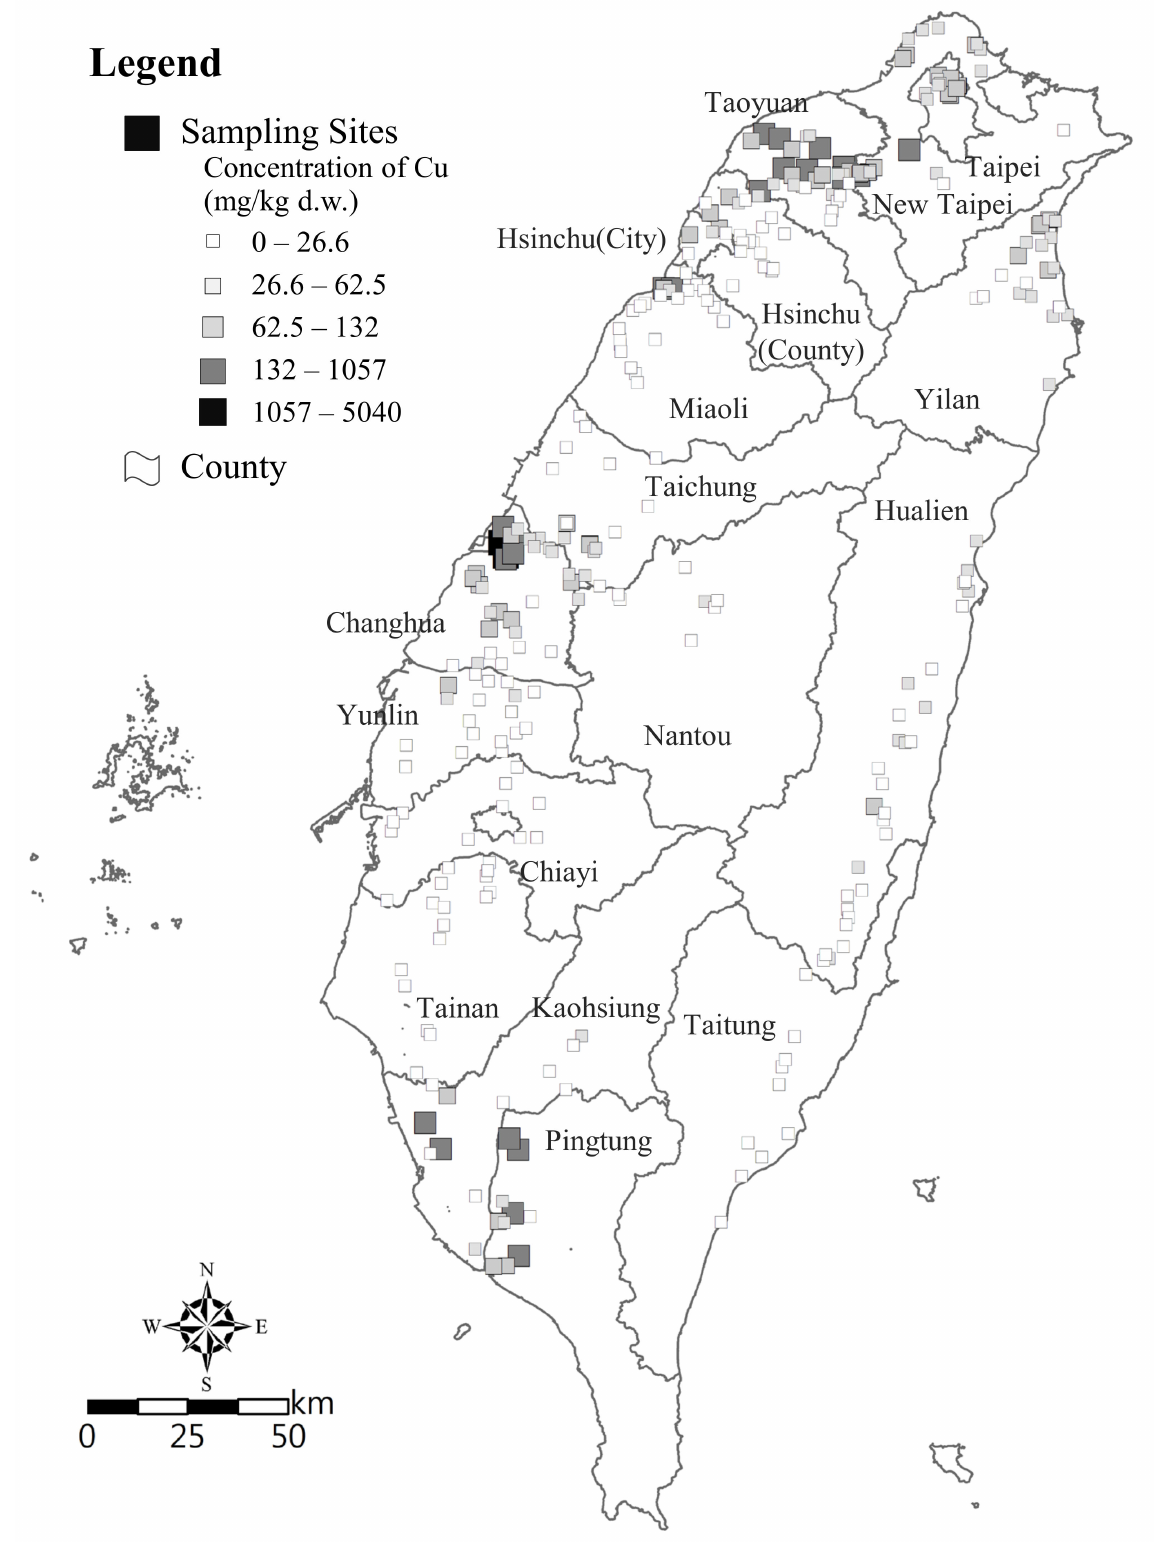
Figure 2. Irrigation canal sediment sampling sites and Cu concentration distribution in